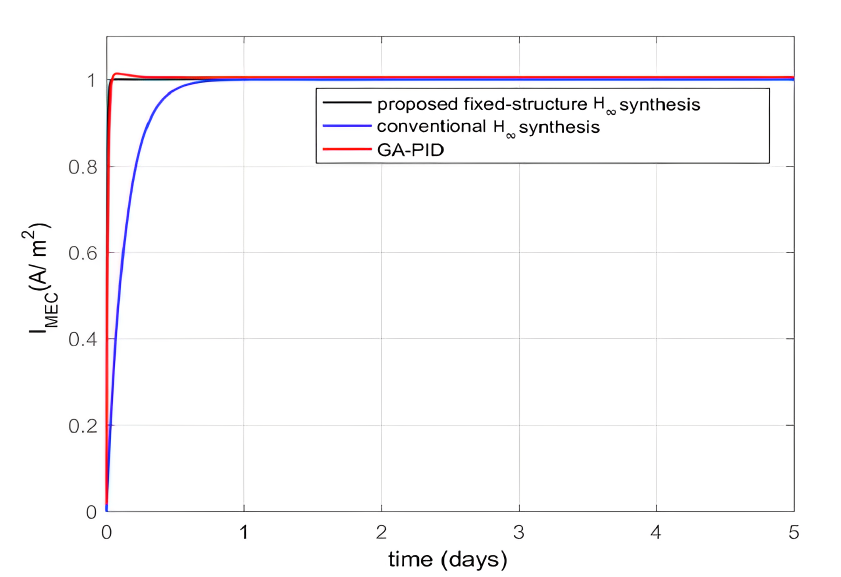
Figure 10. Plot of comparison for controllers with transient specifications.